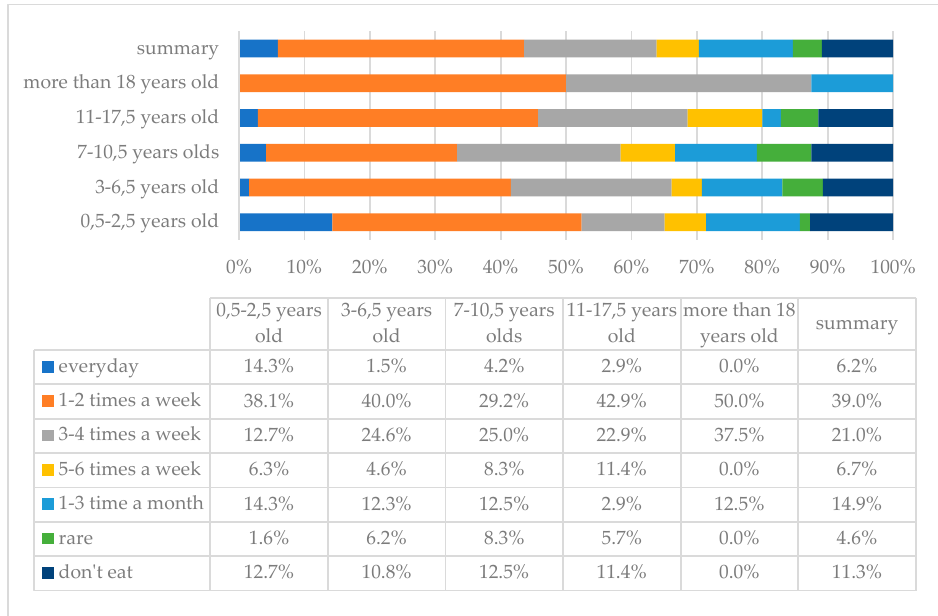
Figure 4. Frequency of egg consumption in the study group of individuals with DS by age. Analysis of the results showed that meat is consumed most frequently several times a week; such an answer was indicated by 107 (54.9%) parents, while 1 (0.5%) of them said that meat products are not eaten by children at all (Figure 5). The most commonly consumed meat in the study group was chicken ( n = 155, 79.5%), turkey ( n = 109, 55.9%), and pork ( n = 101, 51.8%) (more than one answer